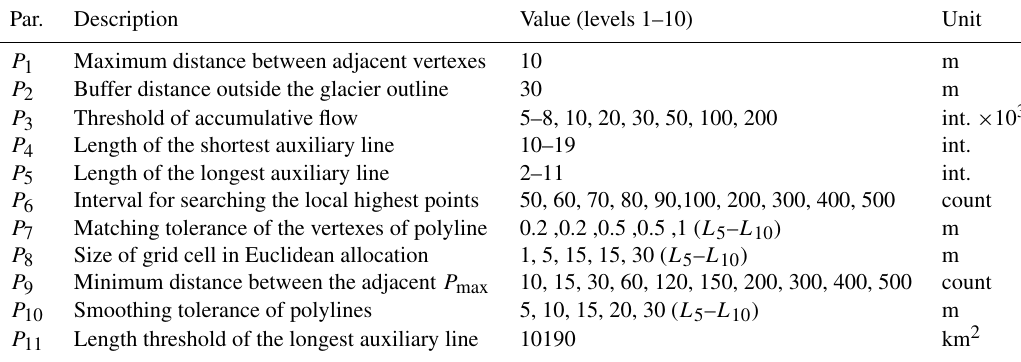
Table A1. Parameterization scheme for extracting global glacier centerlines.